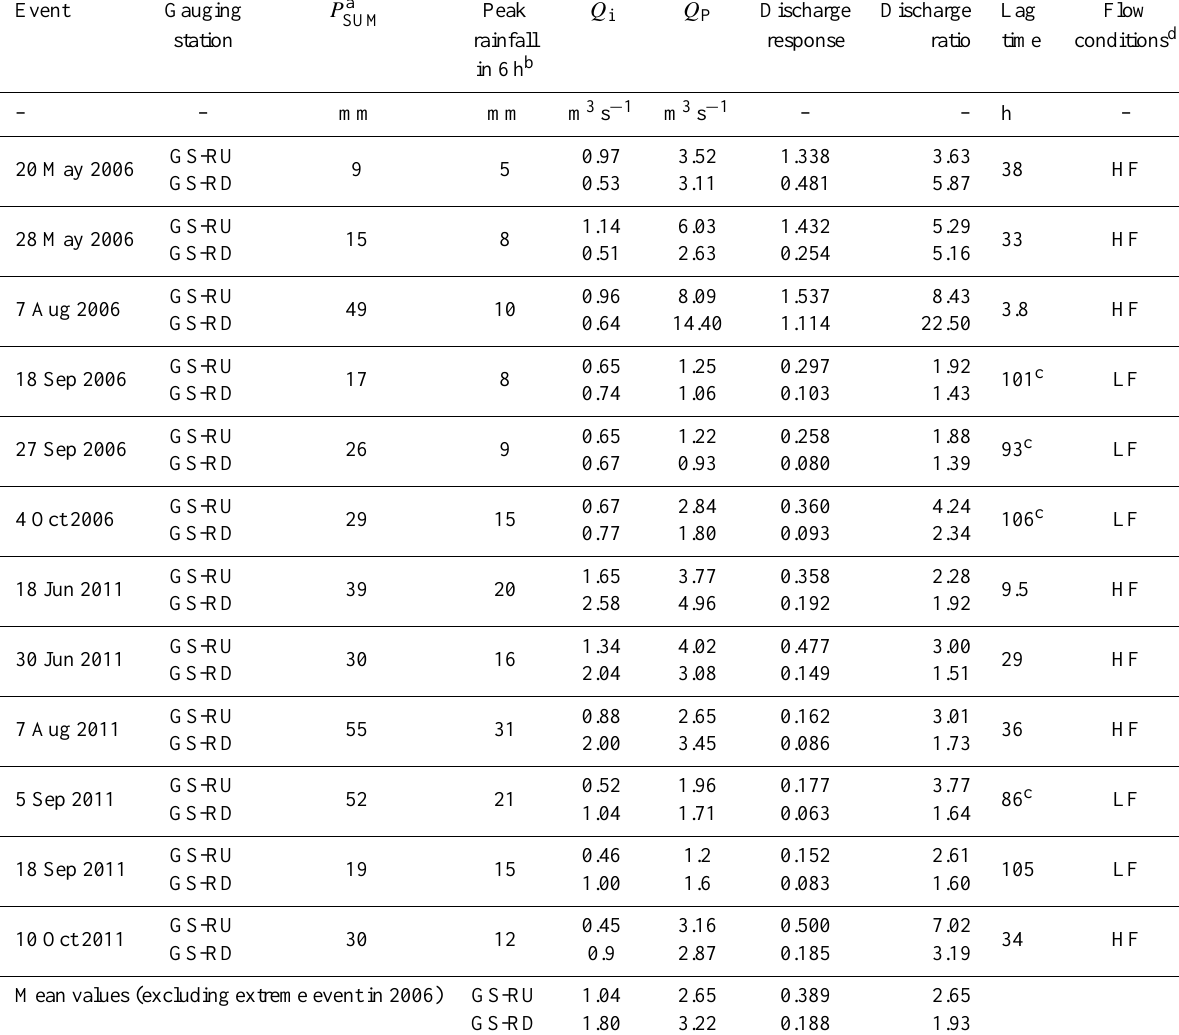
Table 2. Discharge characteristics of selected precipitation events in 2006 and 2011. All events with a peak discharge Q P > 2.3 ± 0.2m 3 s − 1 are high-flow events. Q i : initial discharge; Q P : peak discharge; discharge response: ratio between direct discharge ( Q P − Q i ) and pre- cipitation, conversion factor, and catchment area ( P peak · f c · A ); discharge ratio: quotient between Q P and Q i ; lag time: time difference between discharge peak upstream (GS-RU) and downstream (GS-RD) from the rockfall aquifers; flow conditions indicate high-flow (HF) and low-to-moderate-flow conditions (LF/MF) of the individual